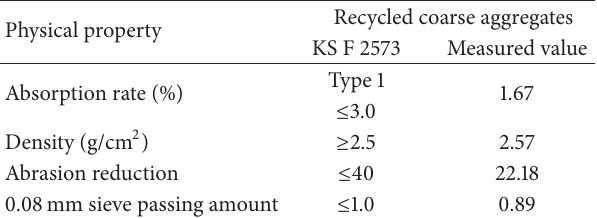
Table 4: The properties of recycled aggregates.